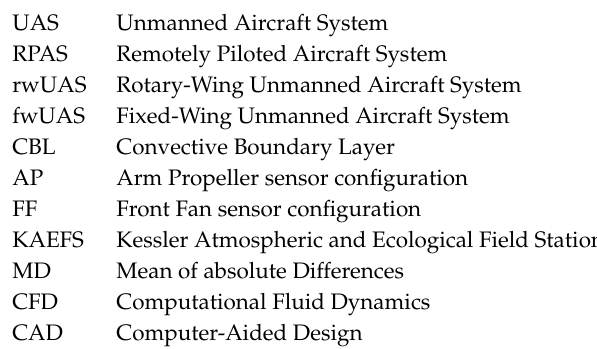
Figure S1: Flight 2—Wind Estimator Off, Figure S2: Flight 3—Wind Estimator